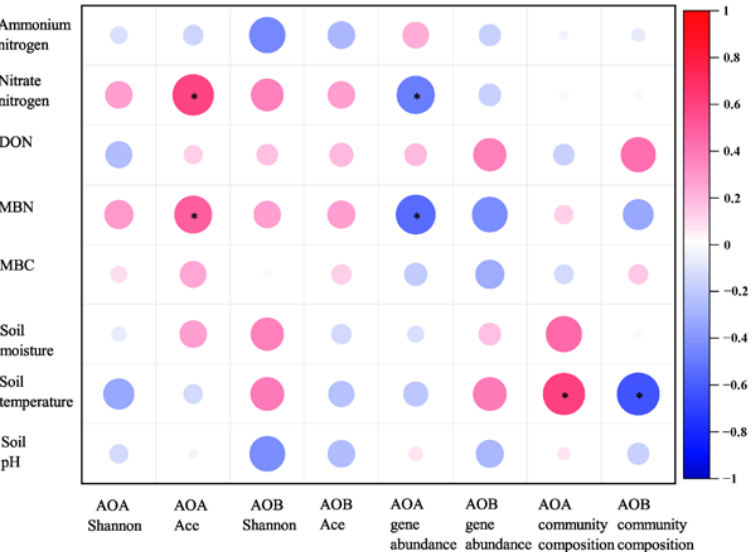
Figure 6. Correlation analysis between soil variables and AOA or AOB gene abundance, community diversity, and community composition. TDN: total dissolved nitrogen; DON: dissolved organic nitrogen; MBN: microbial biomass nitrogen; MBC: microbial biomass carbon. * p < 0.05. Mantel test was performed to assess the correlation between enzyme activities asso- ciated with N cycling and AOA and AOB community factors (Figure 7). Among them, nitrate reductase activity has a significant positive correlation with the AOA Shannon index, AOB Ace index, and AOB community composition but a significant negative correlation with AOA community composition (Figure 7). Nitrite reductase activity has a significant negative correlation with the AOA Ace index (Figure